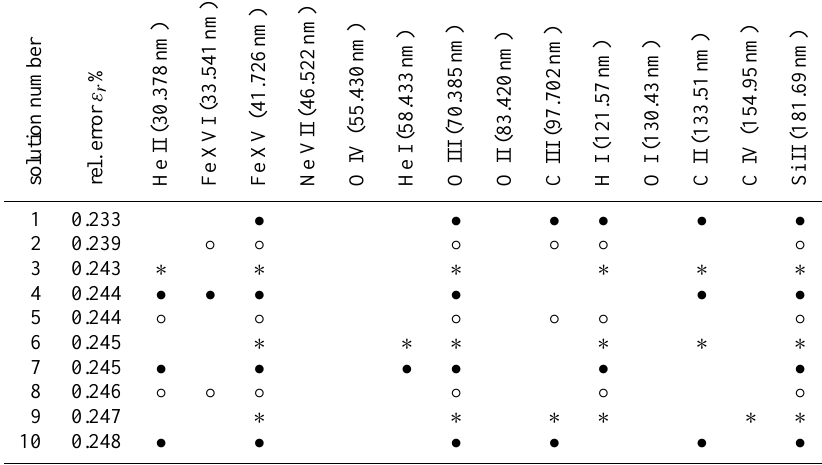
Table 3. Same as Table 2, but with the lines that minimise the average relative